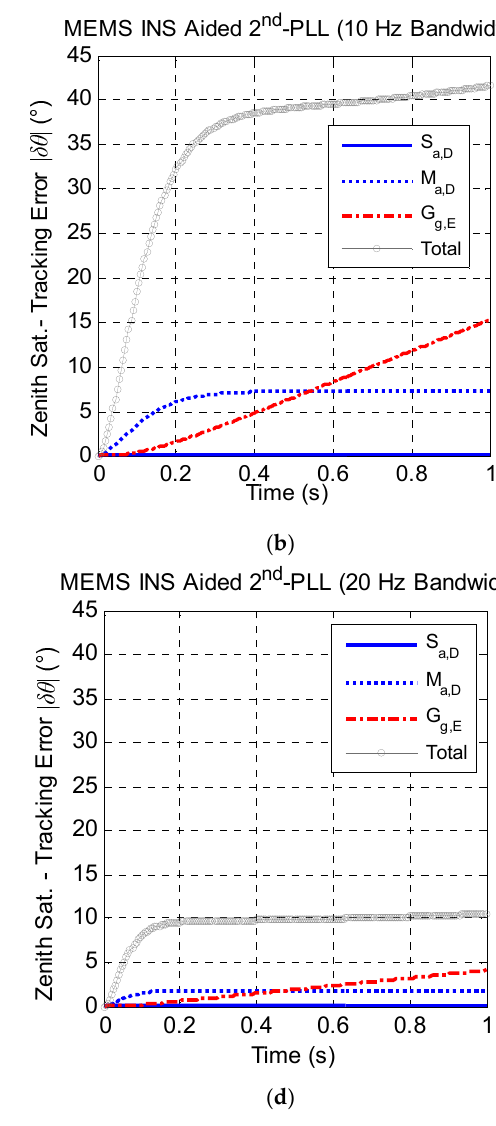
Figure 9. The zenith satellite tracking error caused by MEMS INS error sources under the assumption of linear high dynamics along the north direction. ( a ) Effect of non-maneuver-dependent error with a 10-Hz bandwidth; ( b ) effect of maneuver-dependent error with a 10-Hz bandwidth; ( c ) effect of non-maneuver-dependent error with a 20-Hz bandwidth; ( d ) effect of maneuver-dependent error with a 20-Hz bandwidth. (* Here, Sat. is the abbreviation of satellite.)